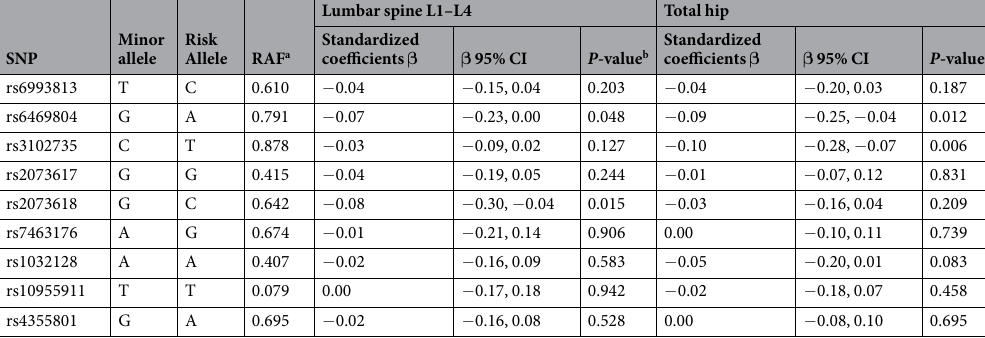
Table 2. Association of 9 SNPs with BMD at Lumbar spine L1–L4 and total hip. a RAF, risk allele frequency. b P -value of significance was set at 0.006 by using the Bonferroni Correction.